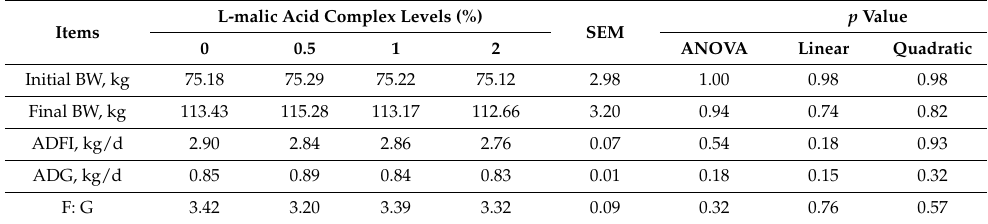
Table 2. Effects of dietary supplementation with L-malic acid on the growth performance of finishing pigs ( n = 6).